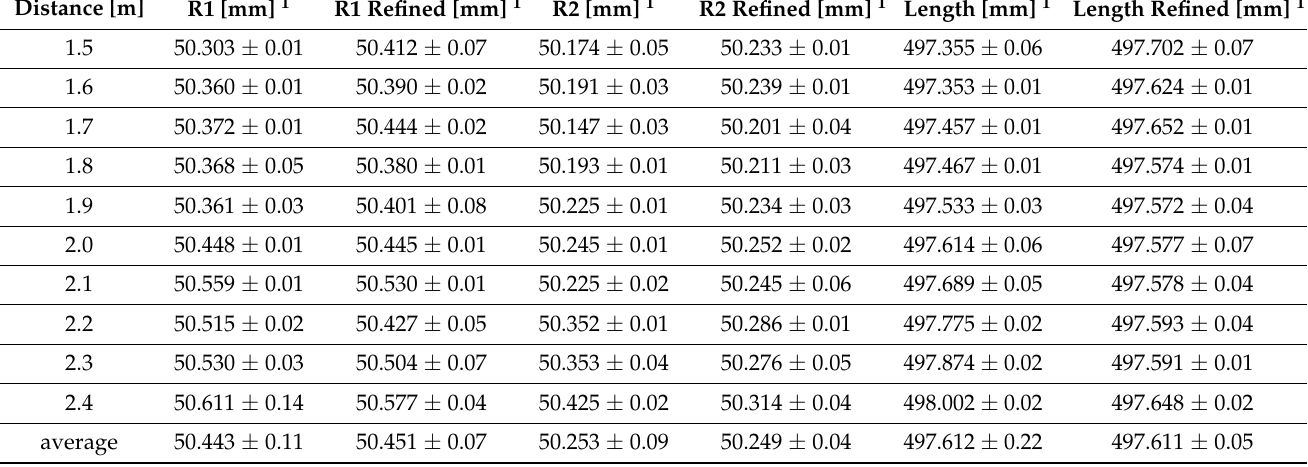
Table 1. Results of spherical diameter and ball-bar measurements without and with error compensa- tion (refinement). Standard deviation values of the single measurements are obtained from two to four independent